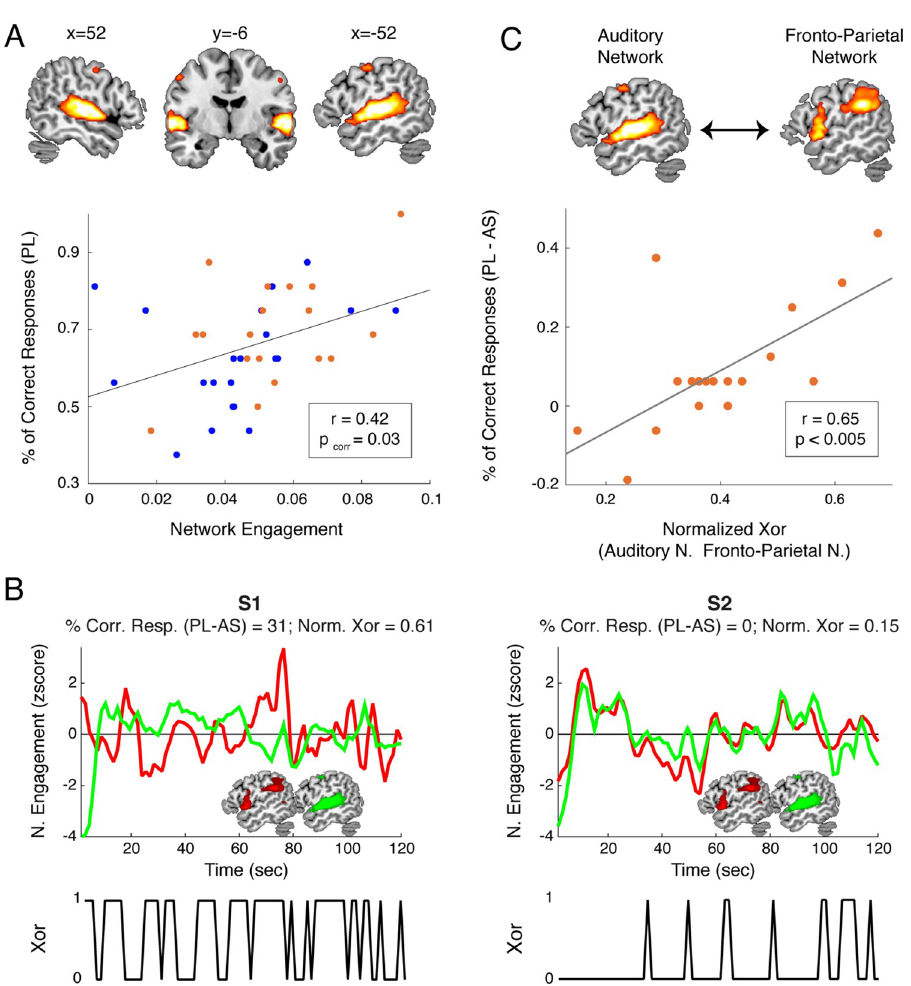
Fig 4. An interplay between networks boosts learning. (A) The auditory network supports learning during PL. Upper panel: In red/yellow, the auditory network is shown over a canonical template, with MNI coordinates on the upper portion of each slice. Neurological convention is used with a p < 0.05 FWE-corrected threshold at the cluster level, with an auxiliary p < 0.001 threshold at the voxel level. Lower panel: Scatterplot displaying participants’ percentage of correct responses during PL as a function of the auditory network’s engagement. (B) The learning benefit during PL (correct answers in PLcorrect answers in AS) is related to the interplay between the time courses of the frontoparietal (red) and the auditory (green) networks. Left/right panel: a representative high synchronizer with a greater/smaller learning benefit. Lower panels: Time evolution of the XOR analysis. (C) Scatterplot displaying high synchronizers’ learning benefit as a function of the normalized XOR between the frontoparietal (red) and the auditory (green) networks. Red line: correlation of the data. Data for Fig 4B and 4C can be found in S4 Data. Data for Fig 4A can be found in S7 Data. FWE, family-wise error; MNI, Montreal Neurological Institute; PL, passive listening.